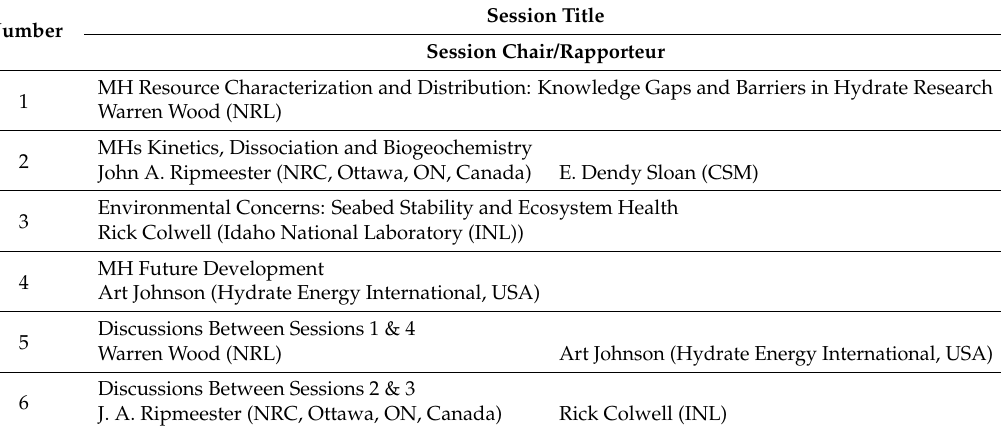
Table 5. Breakout sessions (title and